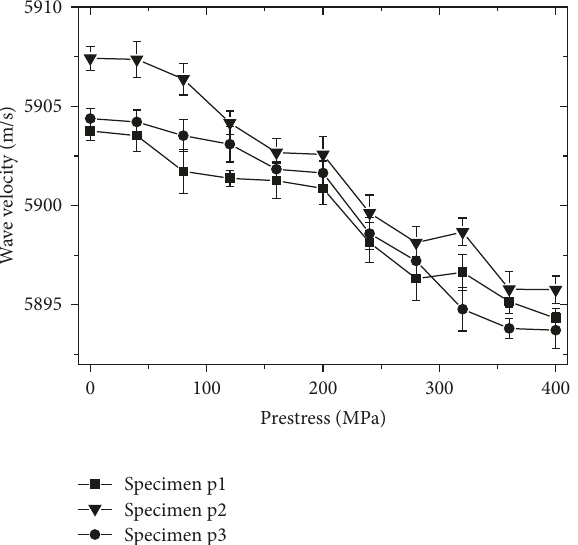
Figure 11: The relationship between the wave velocity and prestress